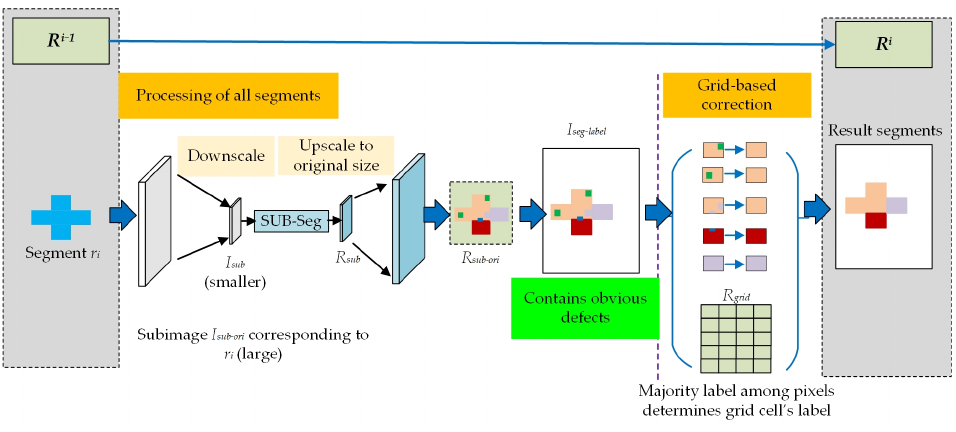
Figure 4. Process of